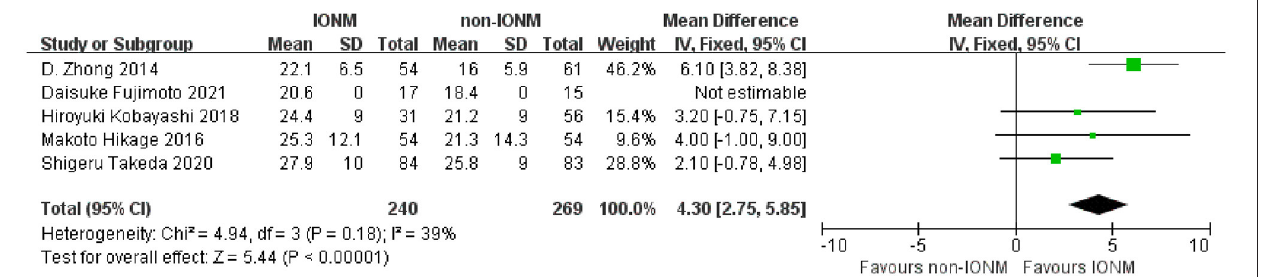
Frontiers in Surgery |